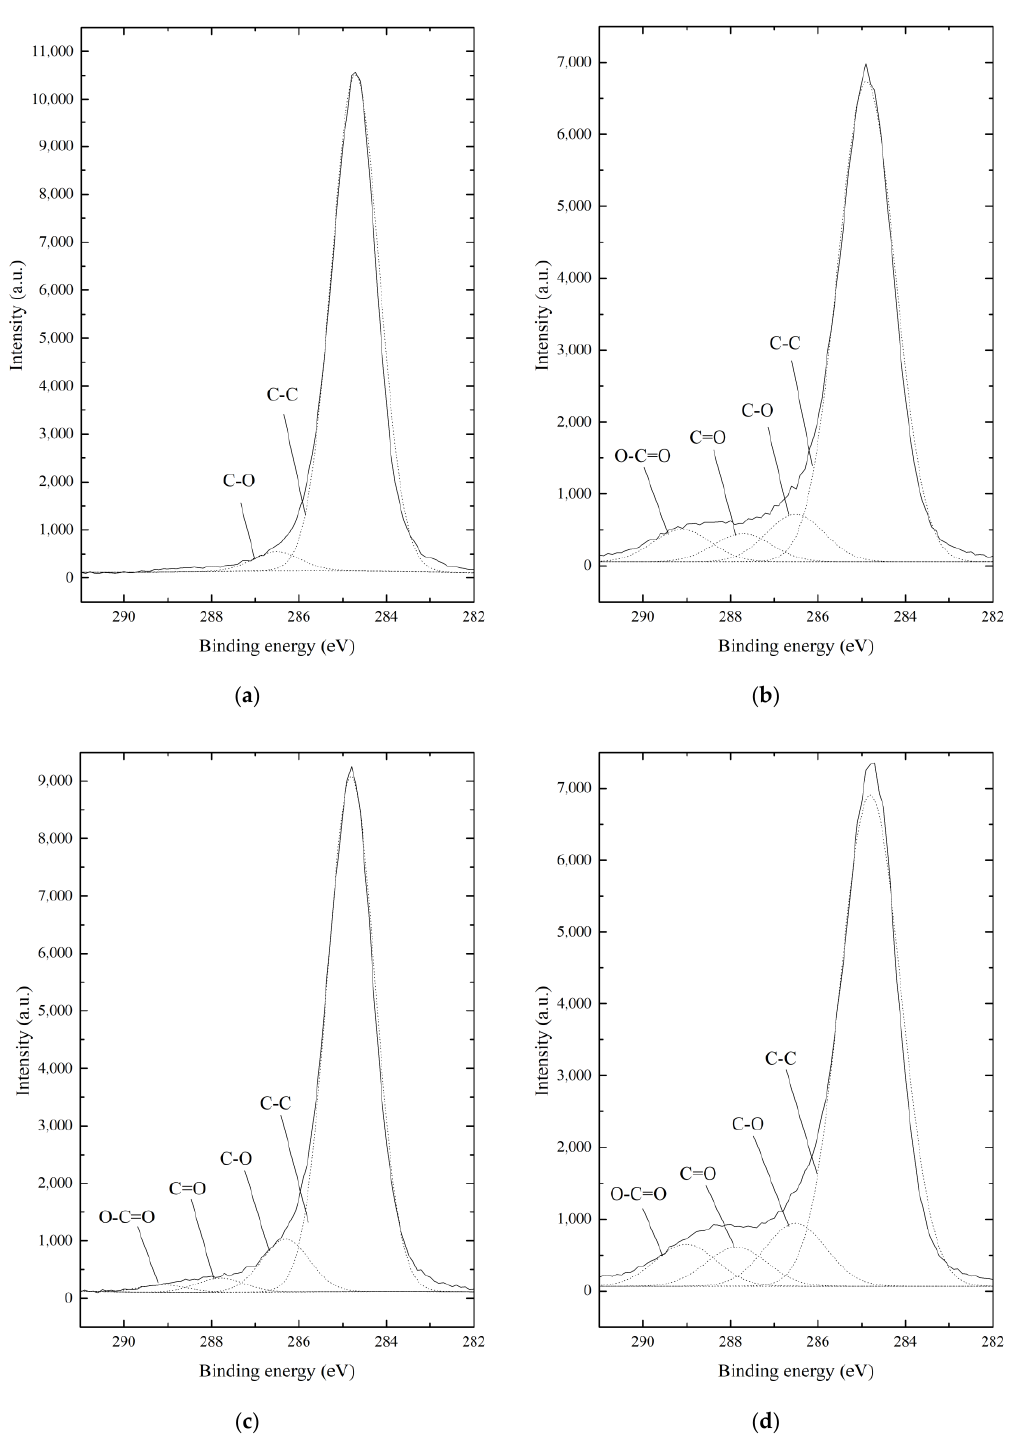
Figure 13. C1s spectra of the PE surface after being treated by ( a ) none, ( b ) APPJ only, ( c ) sanding only, and ( d ) both sanding and APPJ.